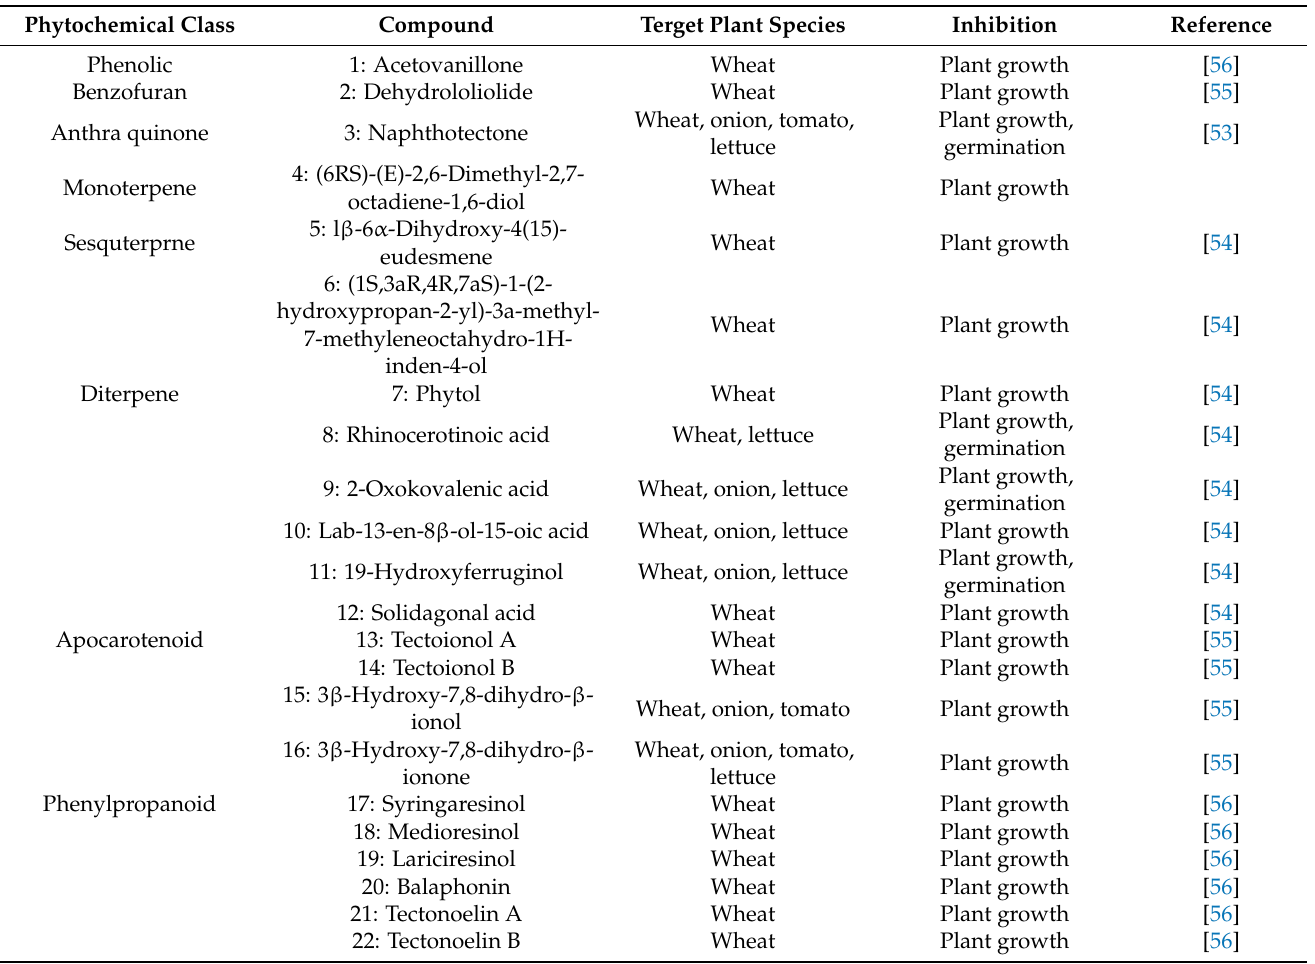
Table 2. Phytotoxic substances in teak with allelopathic effects on crop plant species. Phytochemical